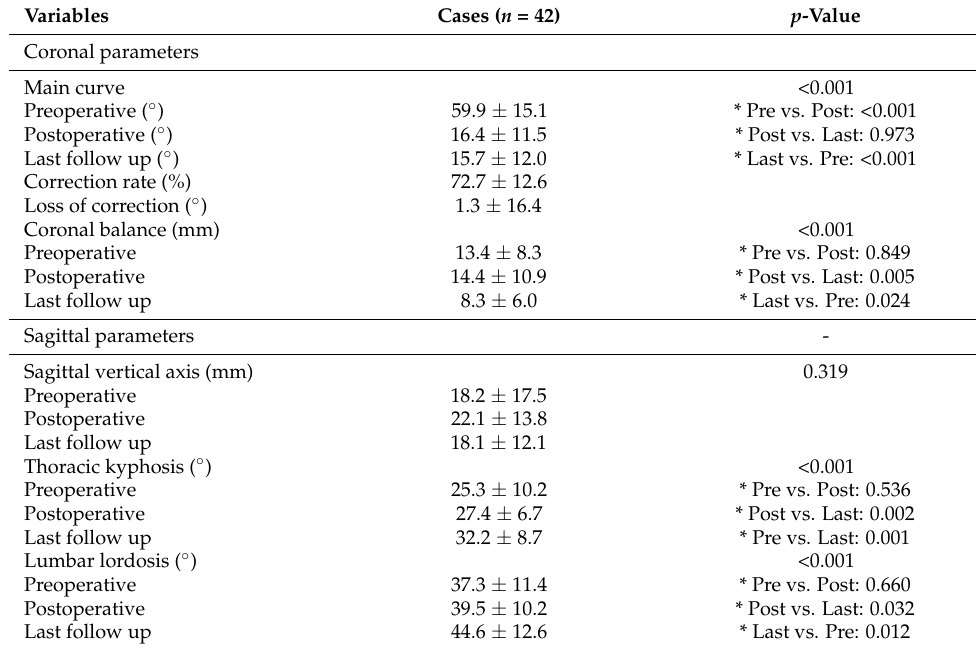
Table 2. Radiological parameters of this